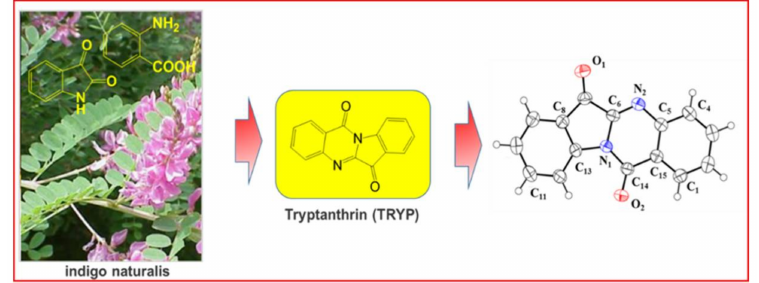
Figure 1. Chemical and monocrystal structures of TRYP.